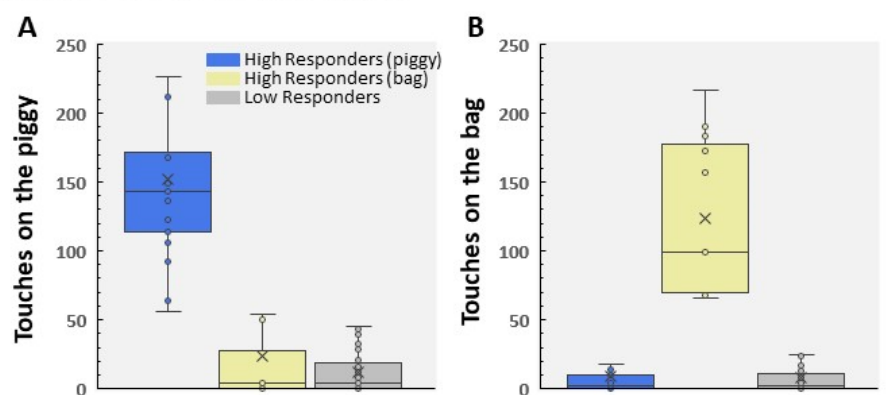
Figure 2. Mean of touches to the piggy ( A ) and to the bag ( B ). The sample was divided into LR (n = 75) and HR (n = 28), as indicated by Formula (1) in the Index Score for Behavioral Classification section. Furthermore, HR participants were assigned to two subgroups: HR to pig (n = 17) and HR to bag (n = 11). The graphs show the different performances followed by the participants. Only 27.2% were considered HR (16.5% to the piggy and 10.7% to the bag); the rest were considered LR. The different performances shown in A and B were statistically significant (both F(2, 102) > 114; both ps < 0.01).